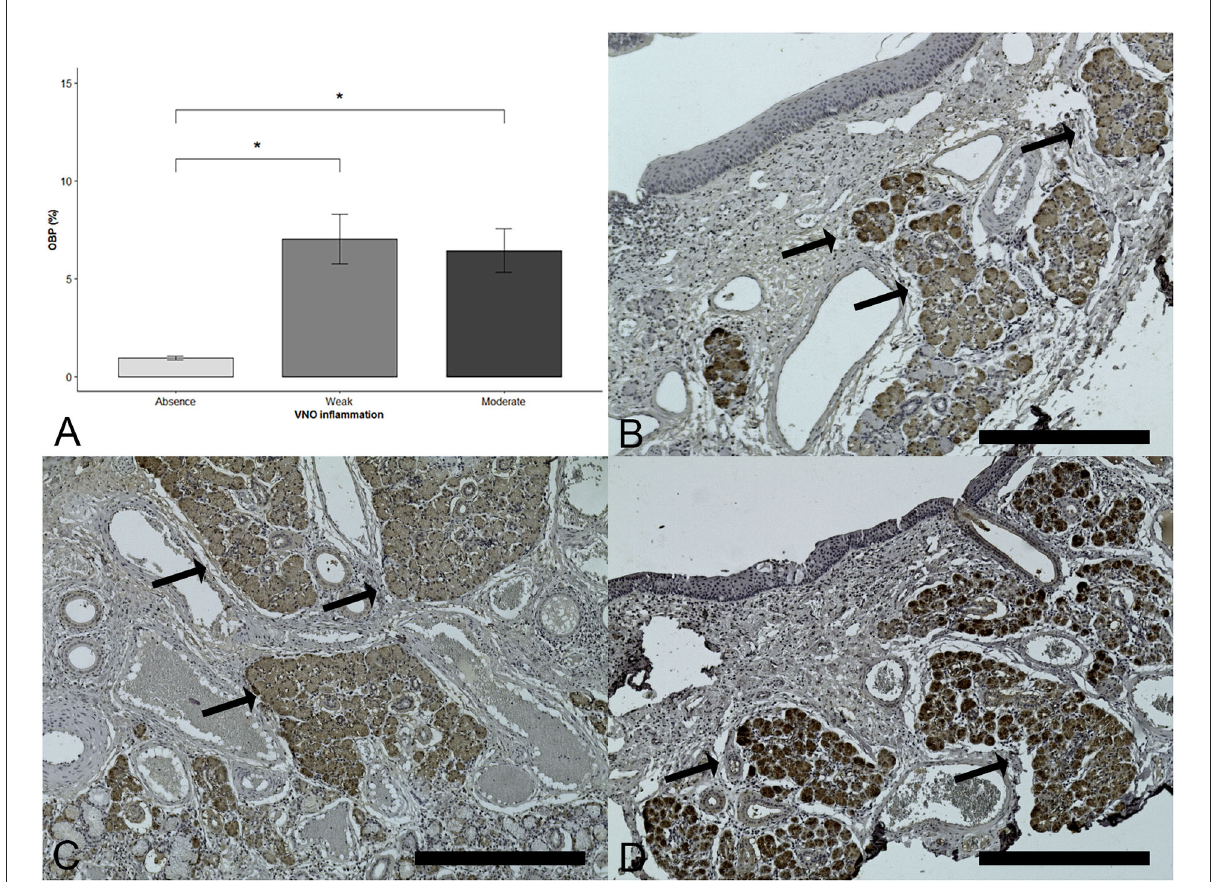
FIGURE4 Odorant-binding protein (OBP) increases with the presence of inflammation in the vomeronasal sensory epithelium. Immunohistochemical staining was used to reveal the presence of OBP (brown staining shown by arrows). (A) Mean of the OBP protein according to the VNO inflammation. Data are expressed in percentages of OBP expression positivity and shown as the mean ± SD (* = p < 0.05). (B) Healthy epithelium, score = 0, (C) Weak inflammation, score = 1, (D) Moderate inflammation, score = 2. (Objective x10, Scale bar 400 µ